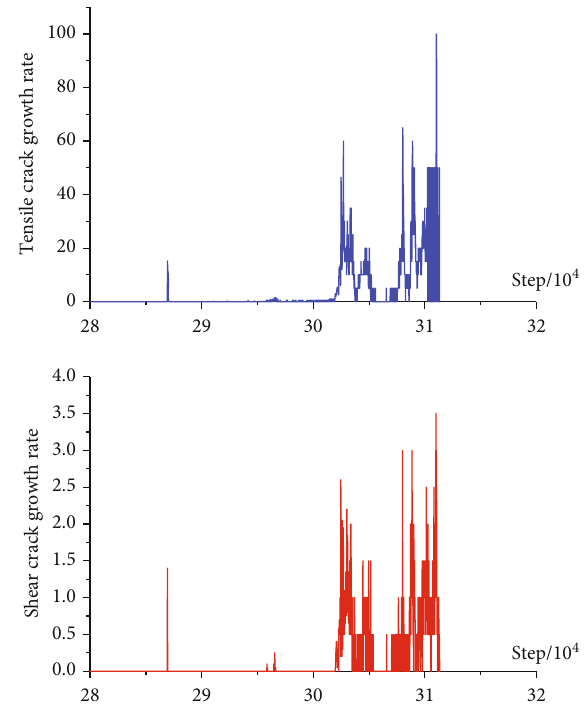
Figure 11: Crack growth rate